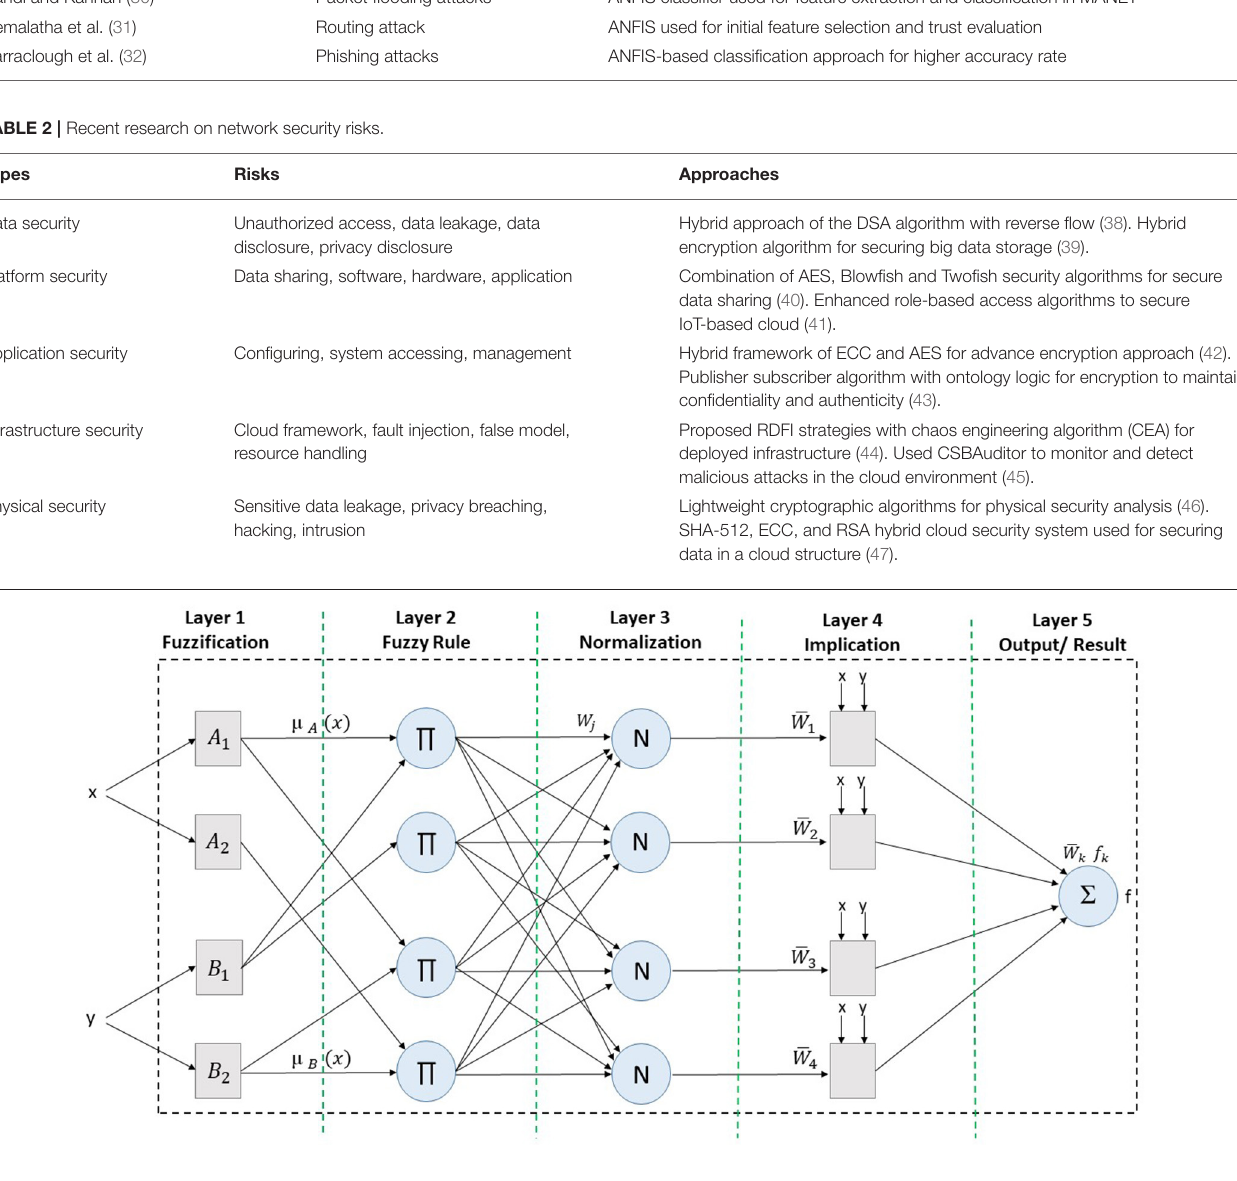
FIGURE 1 | Five layer-based working of the ANFIS